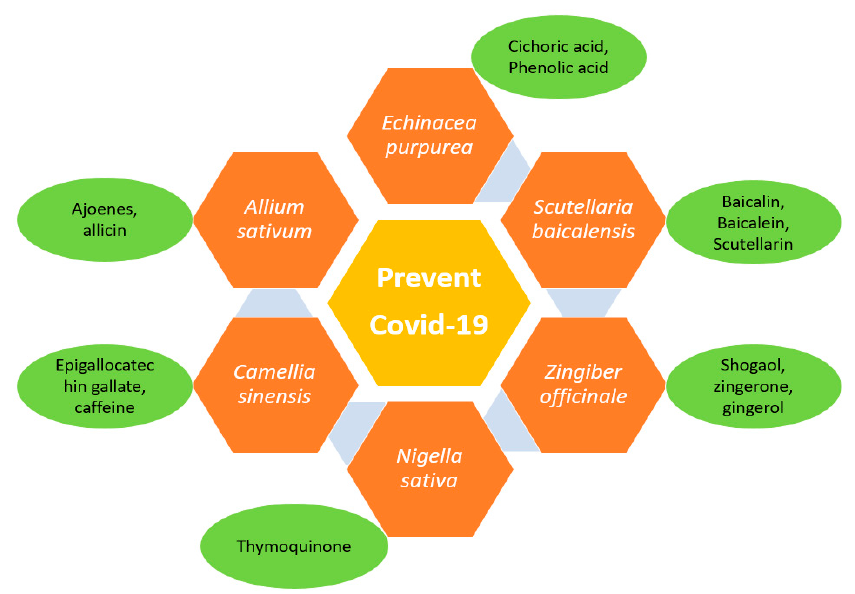
Figure 5. Herbs are effective in preventing COVID-19